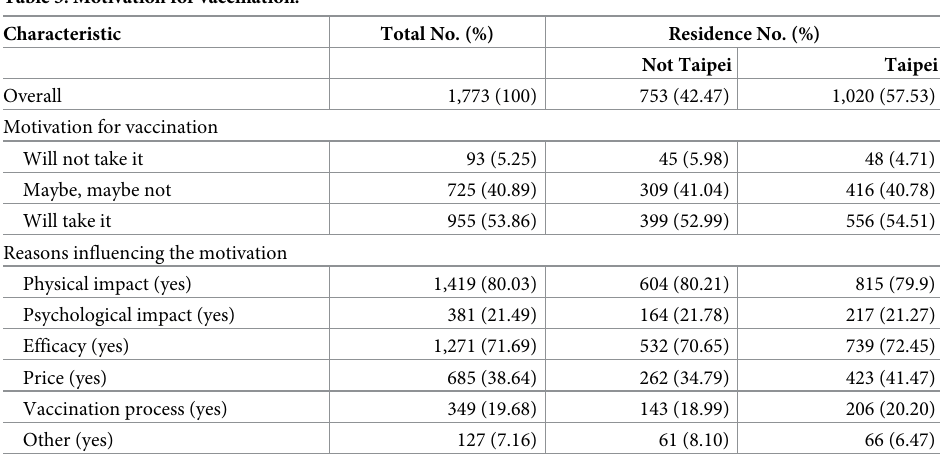
Table 3. Motivation for